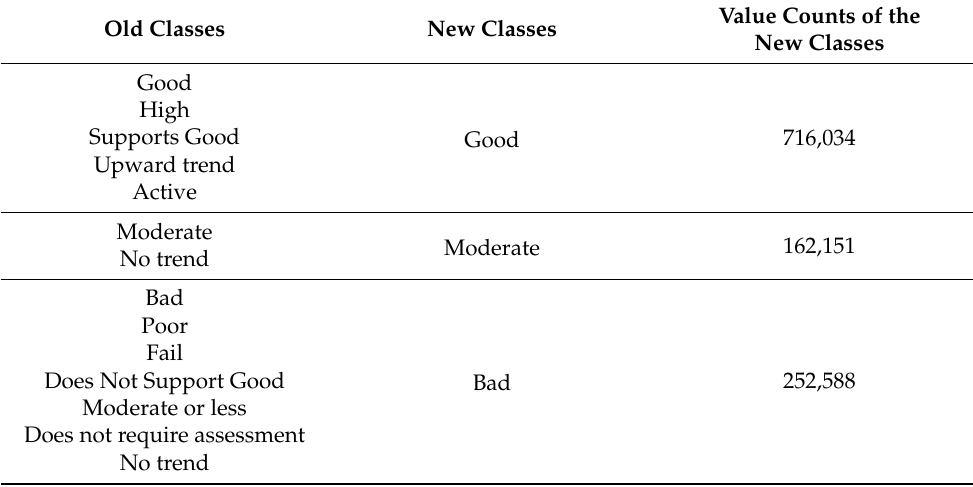
Table 3. The “Status” column’s old and new classes and the value counts of the new